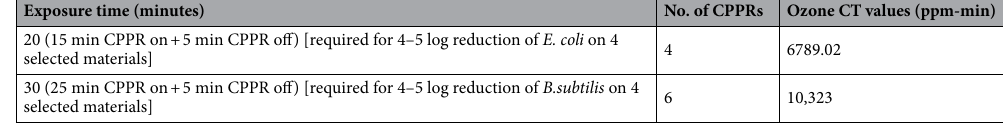
Exposure time (minutes)